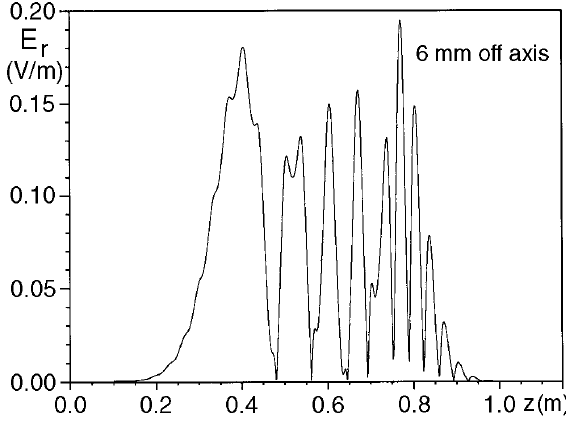
FIG. 11. MAFIA : transverse (cid:69) field of mode #16.